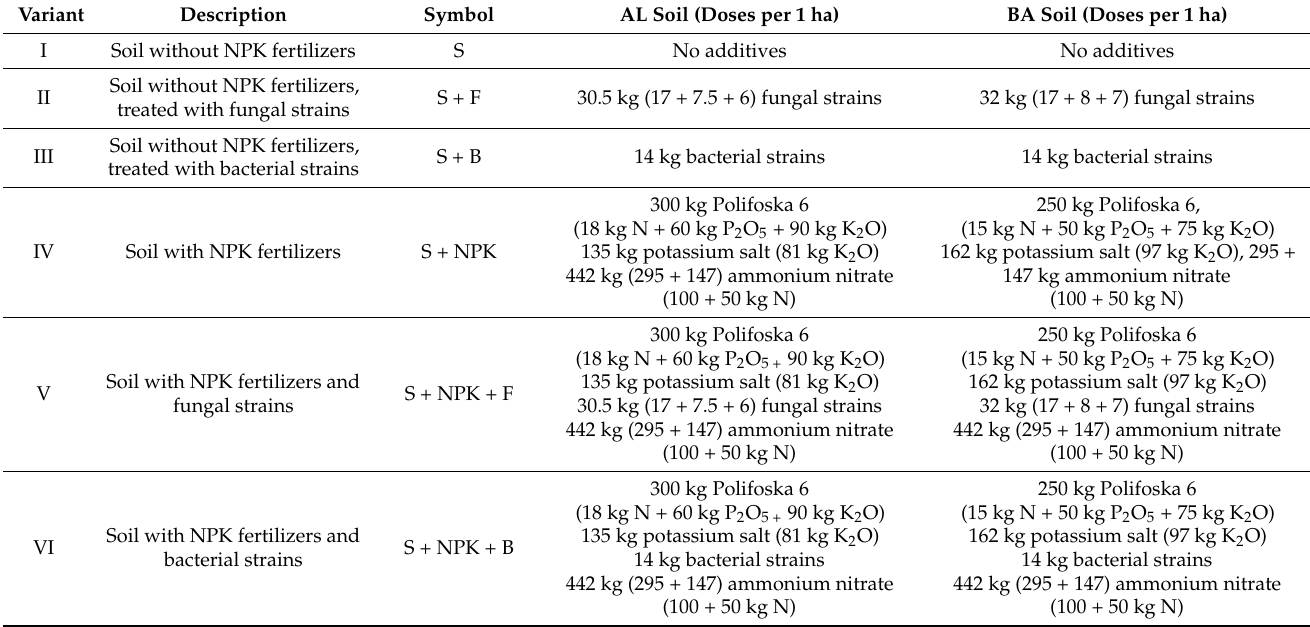
Table 4. Annual fertilization plan for Abruptic Luvisol (AL) and Brunic Arenosol (BA) soils. The same scheme was used in the second year of the experiment. Doses of mineral fertilizers, and fungal and bacterial strains were calculated separately for each soil on the basis of soil properties and requirements for maize